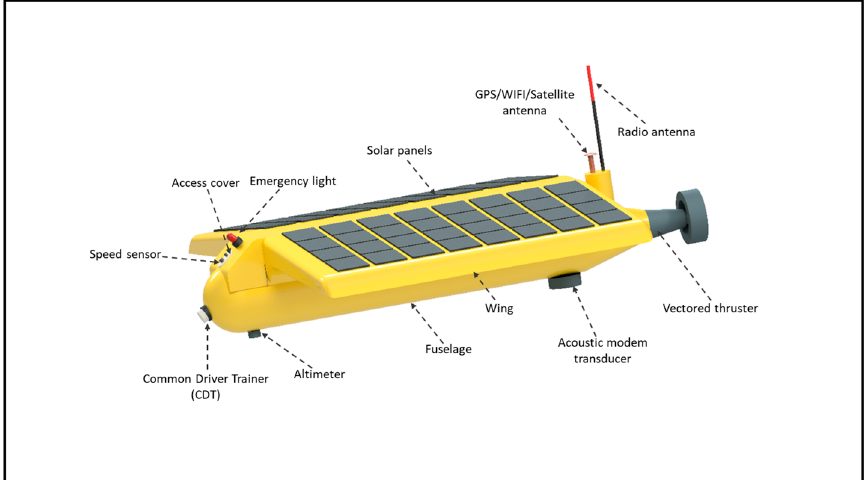
Figure 7. Model of solar-based autonomous underwater vehicle.